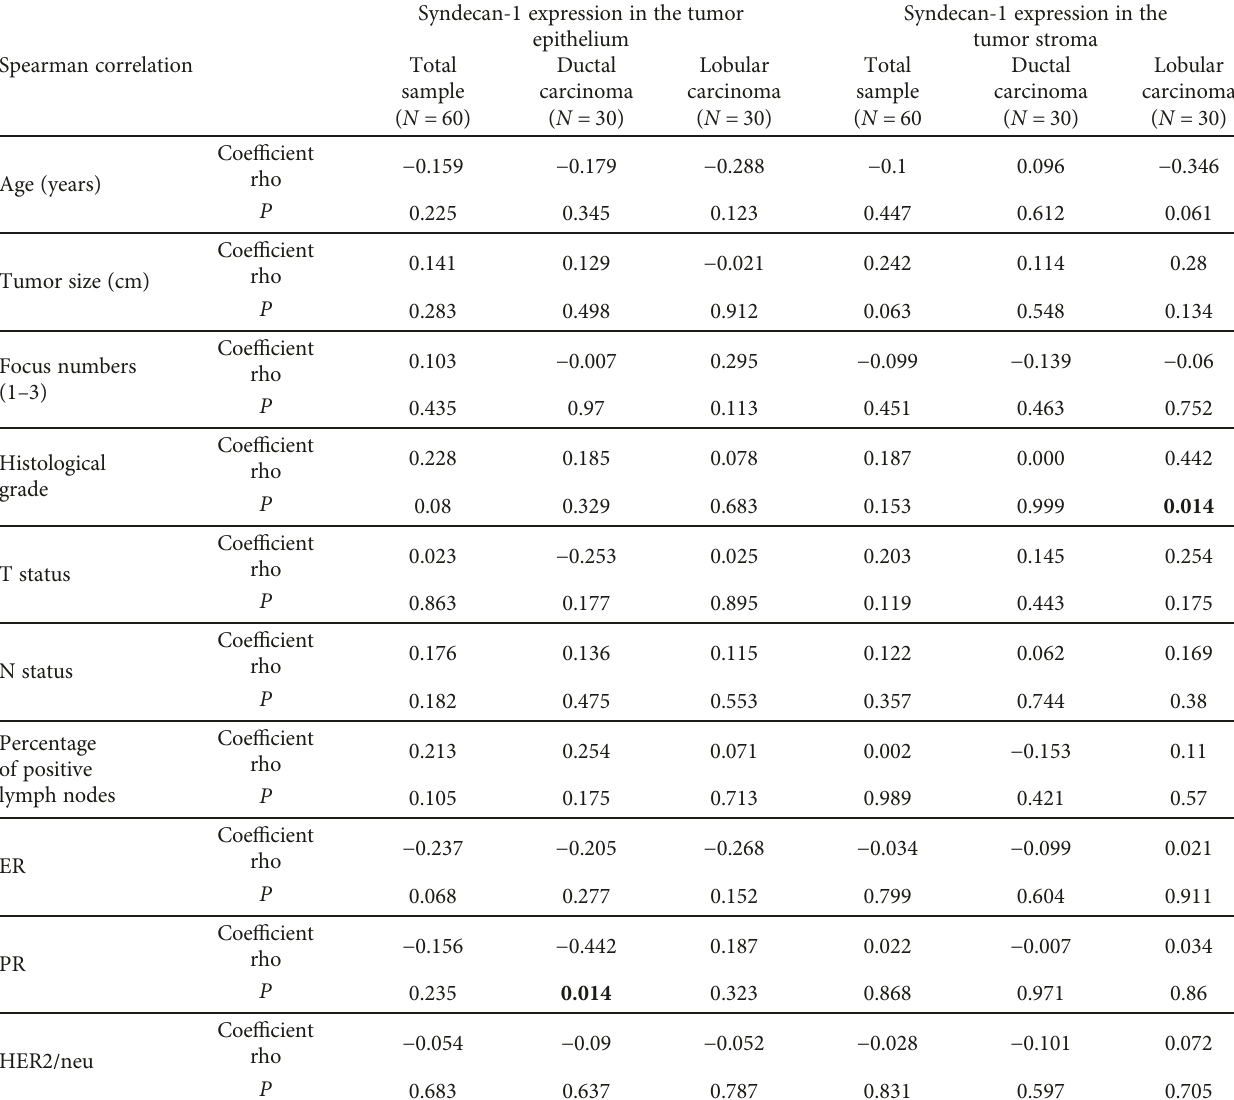
Table 4: The correlation between the Sdc1 expression in the tumor epithelium and the stroma of the total sample of both types of the primary tumors and separately of the invasive ductal and the lobular carcinomas, with various clinical and histological parameters analyzed using Spearman ’ s correlation coe ffi